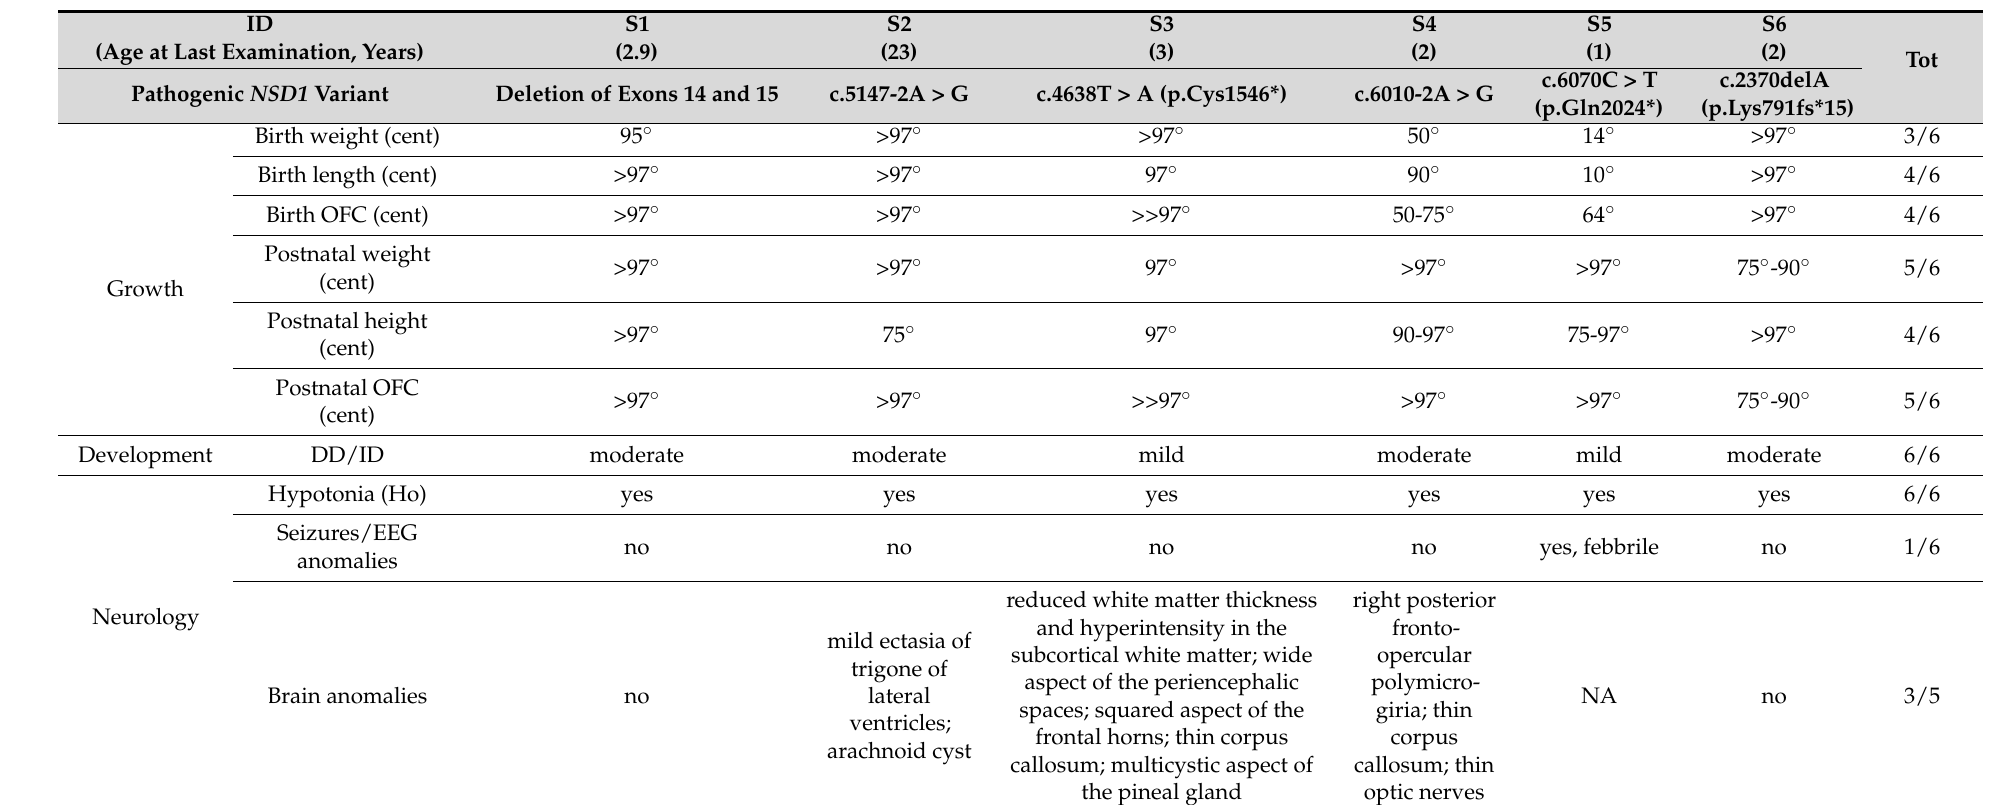
Table 1. Clinical and molecular features of the subjects included in the study